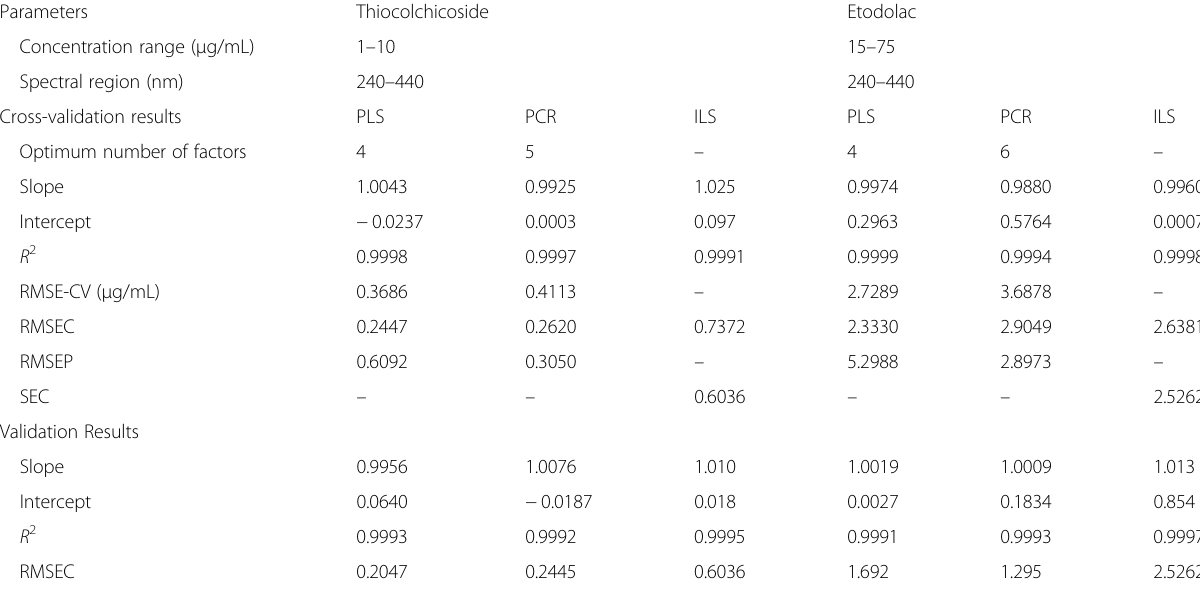
Table 1 Obtained statistical values for the simultaneous analysis of ET and TC multivariate calibration methods (PLS, PCR, and ILS)